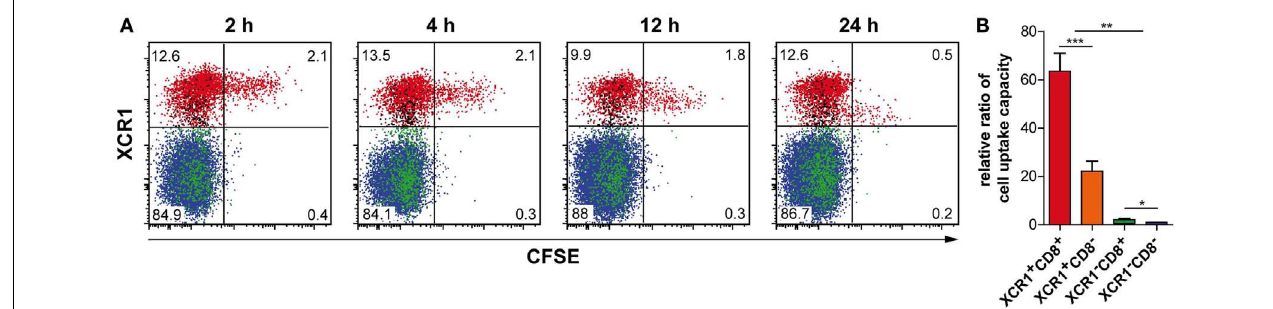
levels of XCR1 compared to XCR1 + CD8 + DCs. Shown is one representative experiment out of three. (B) Relative ratio of cell uptake capacity, calculated for each animal by setting the frequency of XCR1 − CD8 − DCs exhibiting a CFSE-signal to 1 and calculating the fold higher uptake for the other DC subsets accordingly (mean ± SEM of two independent experiments with three animals each; * p < 0.05; ** p < 0.01; *** p < 0.001).